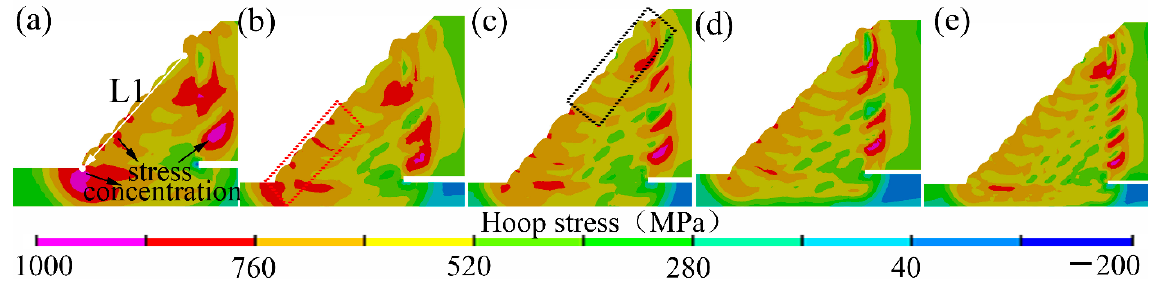
Figure 14. Hoop residual stress distribution: ( a ) case A, ( b ) case B, ( c ) case C, ( d ) case D, ( e ) case E.